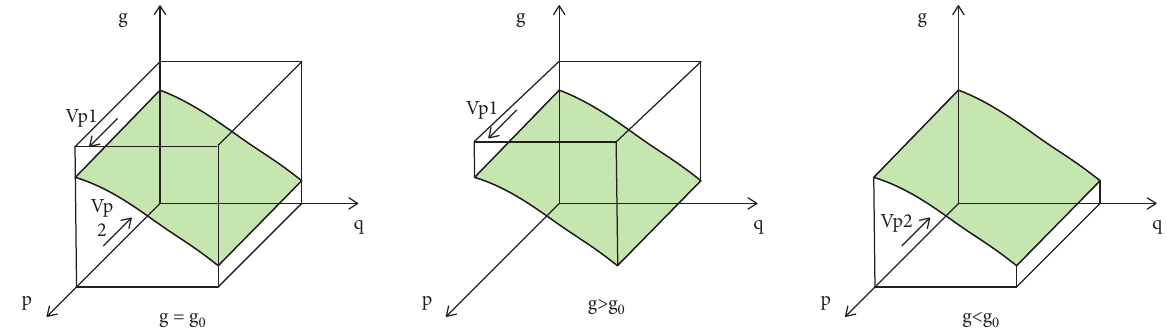
Figure 2: Phase diagram of consumer strategy